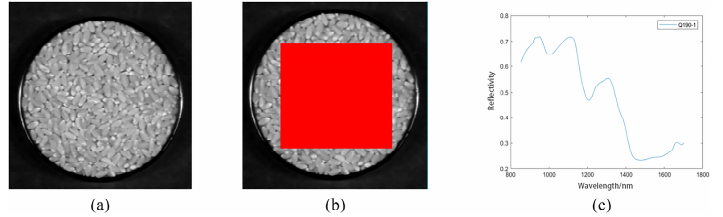
Figure 2. Extracting process of spectral data. ( a ) the corrected image of the sample; ( b ) the selected region of interest; ( c ) the average spectral curve of the region of interest.